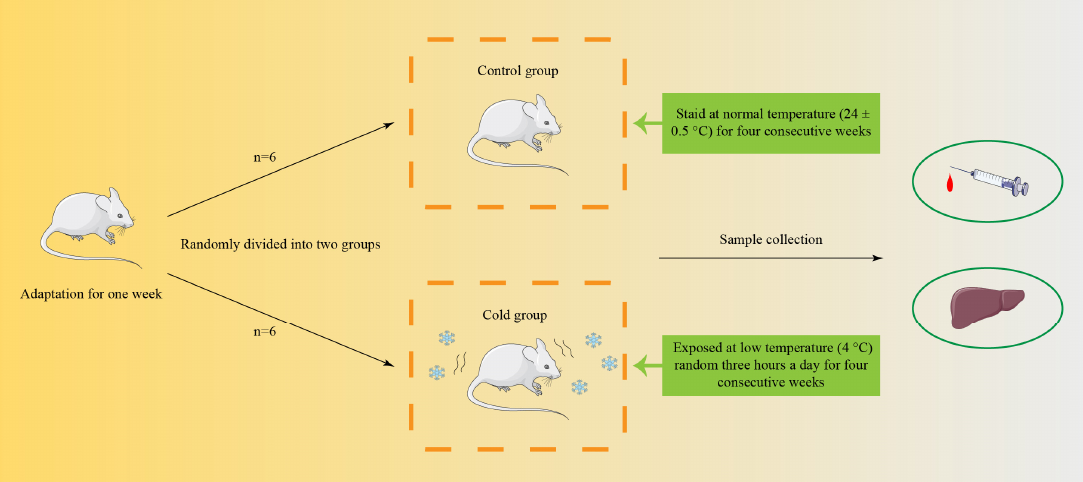
Figure 1. After cold exposure, we collected blood and liver samples and put the blood sample in a refrigerator at 4 ◦ C. The part of liver sample was frozen in liquid nitrogen and stored at − 80 ◦ C for subsequent examination, the rest of liver sample was fixed in 4% paraformaldehyde (Beyotime, Shanghai, China).